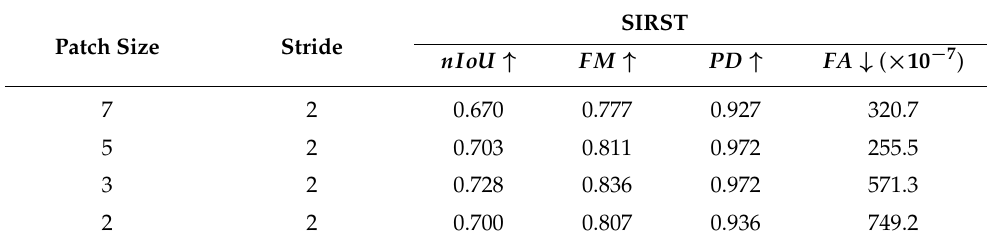
Table 6. Results of different parameters in the OSPE on the SIRST